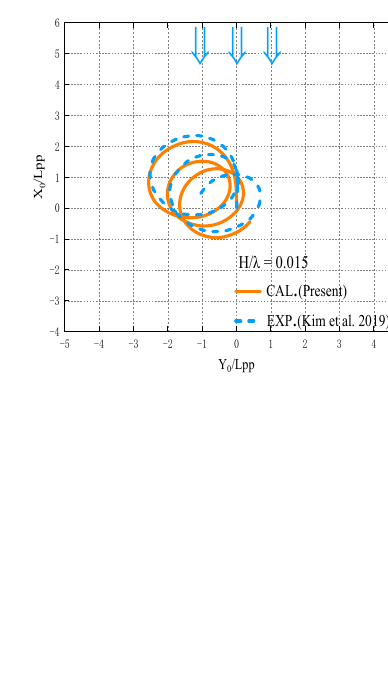
Figure 26. Comparisons of the turning trajectory of −35° turns with the wavelength variation in the beam waves. The experimental values were reproduced from [8], with permission from Elsevier, 2022.